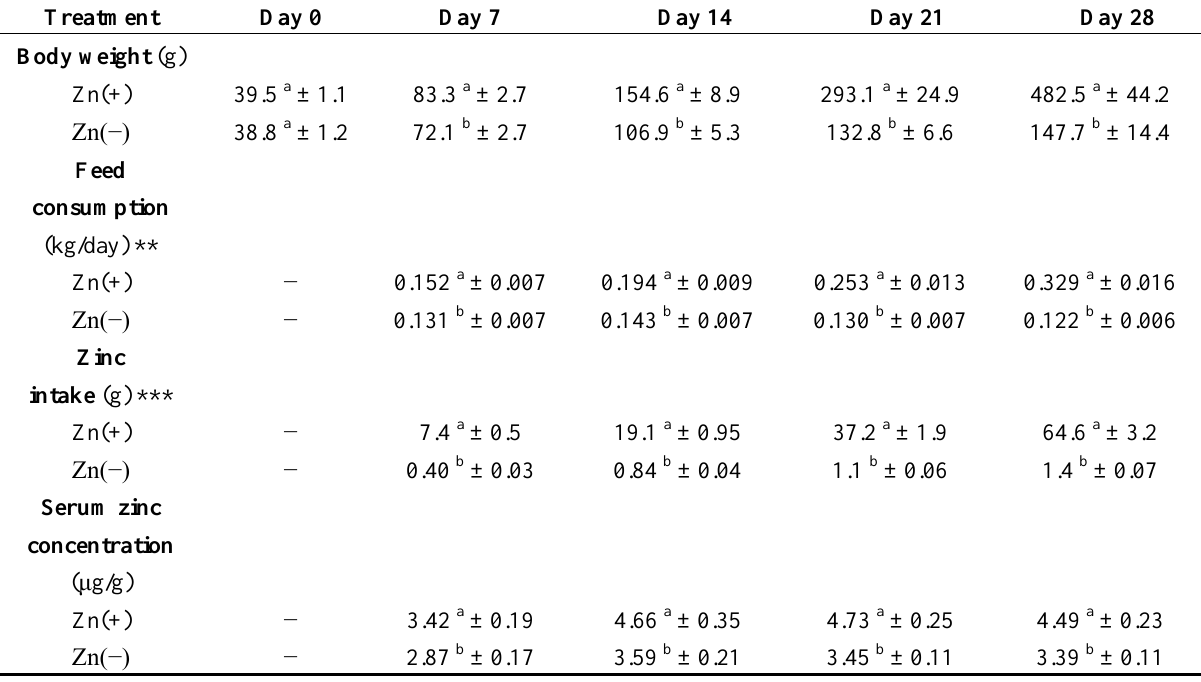
Table 4. Body weight, feed consumption, zinc intake, and serum zinc concentrations in chickens fed a Zn(+) control and Zn(−) diets from day 0 to 28 *. Treatment